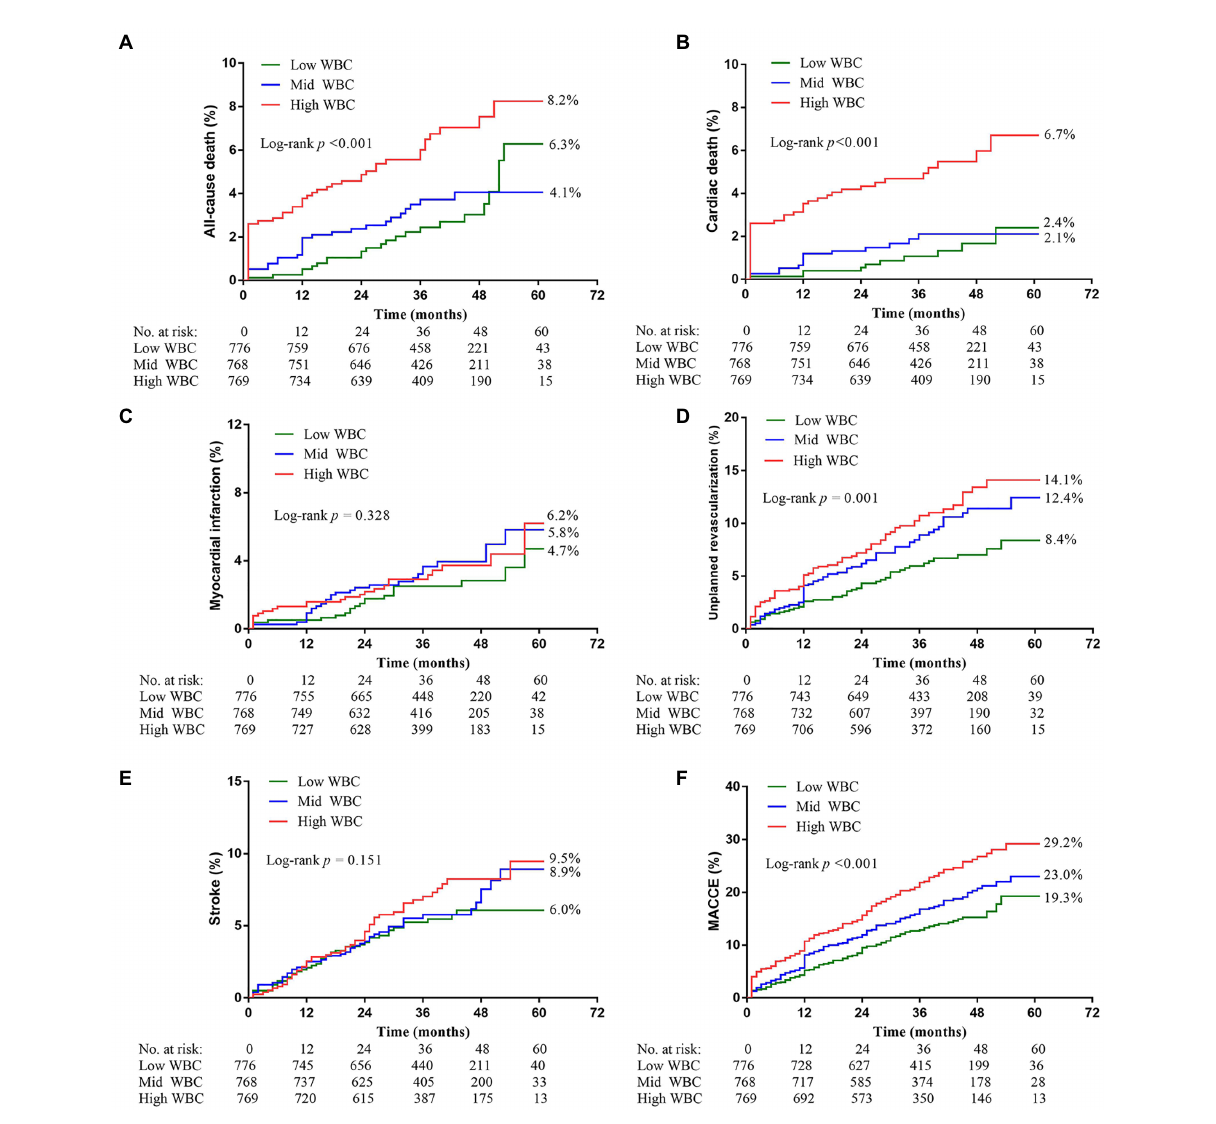
FIGURE 2 Kaplan–Meier curves showing event rates stratified by the WBC counts. (A) All-cause death. (B) Cardiac death. (C) Myocardial infarction. (D) Unplanned revascularization. (E) Stroke. (F) Major adverse cardiovascular and cerebrovascular events